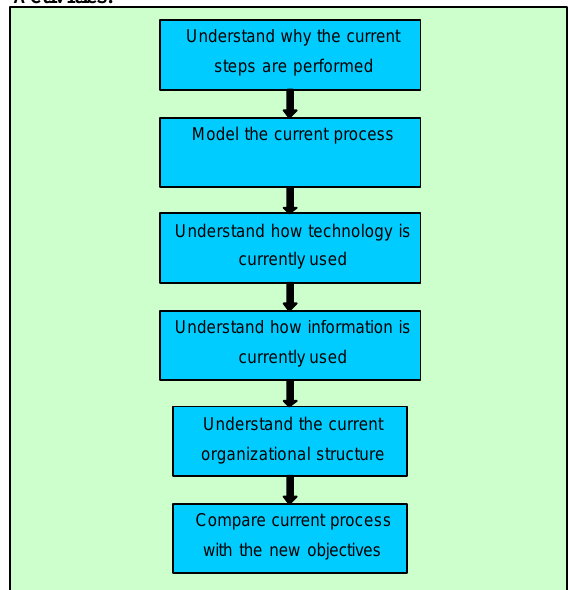
Figure 4: Activities Performed in Phase 4